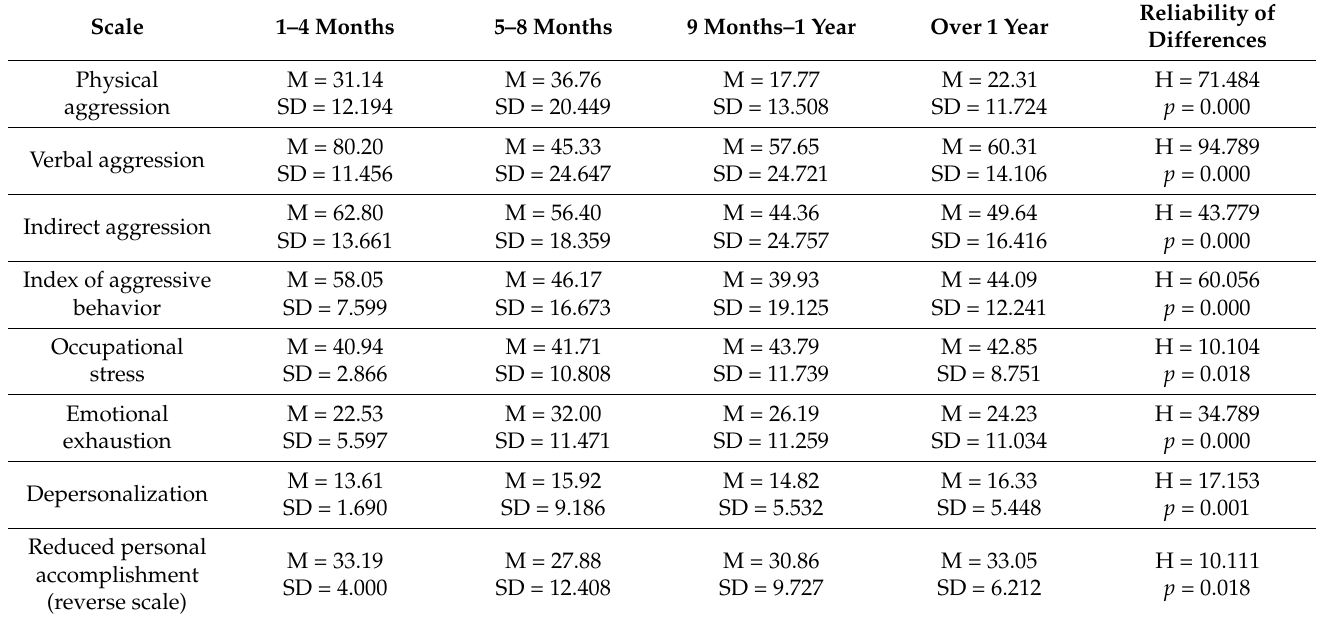
Table 14. Assessment of the average values of the levels of occupational stress, components of occupational burnout, components of aggression, and aggressive behavior in COVID-19 ICU nurses with different employment durations. M is the mean value, SD is the standard deviation, H is the Kruskal–Wallace Criterion, and p is the significance